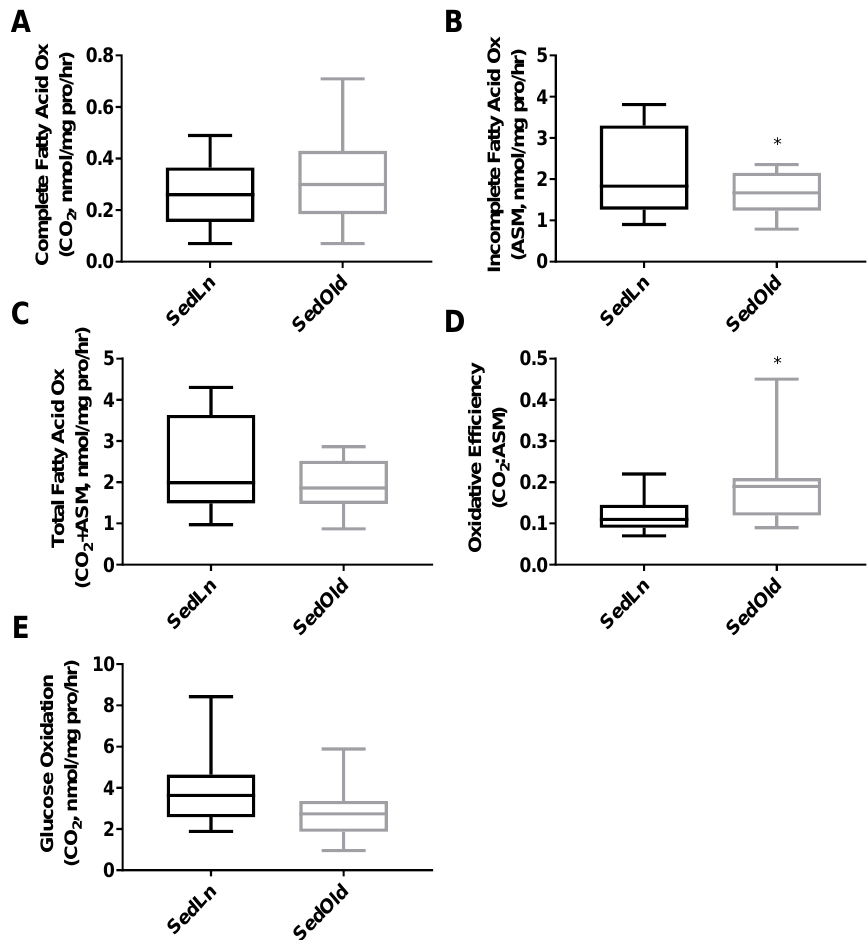
Figure 3. Complete ( A ), incomplete ( B ), and total ( C ) fatty-acid oxidation rates, as well as oxidative efficiency (complete/incomplete) ( D ), and glucose oxidation rates ( E ) of differentiated satellite cells from sedentary young (SedLn) and older donors (SedOld) ( n = 5, BMI 18 – 25 kg/m+2+). (*, **, *** indicating a p -value of <0.05, <0.01, <0.001, respectively).